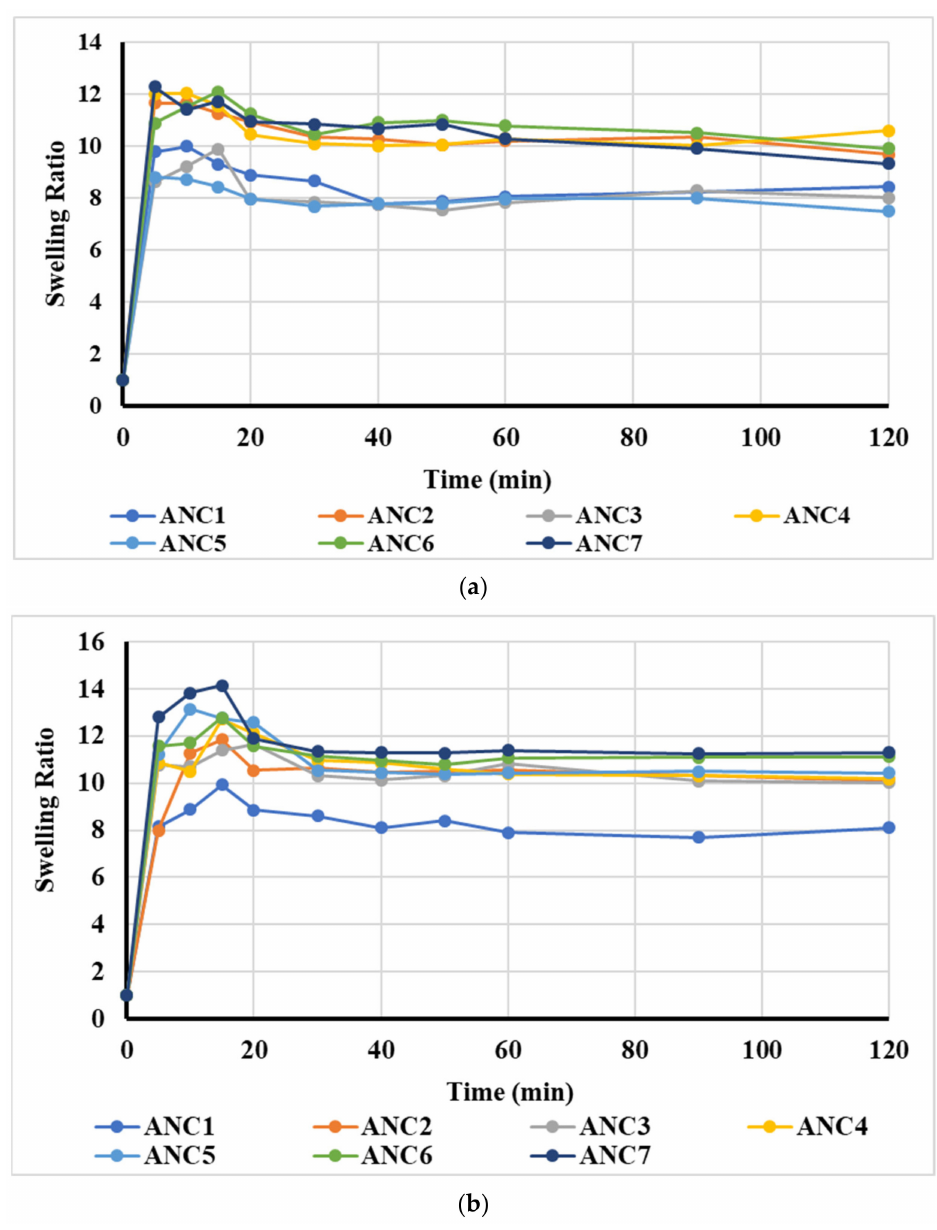
Figure 2. ( a ) The swelling ratio of the developed nanomatrices (ANC1-ANC7) in SGF. ( b ) The swelling ratio of the developed nanomatrices (ANC1-ANC7) in